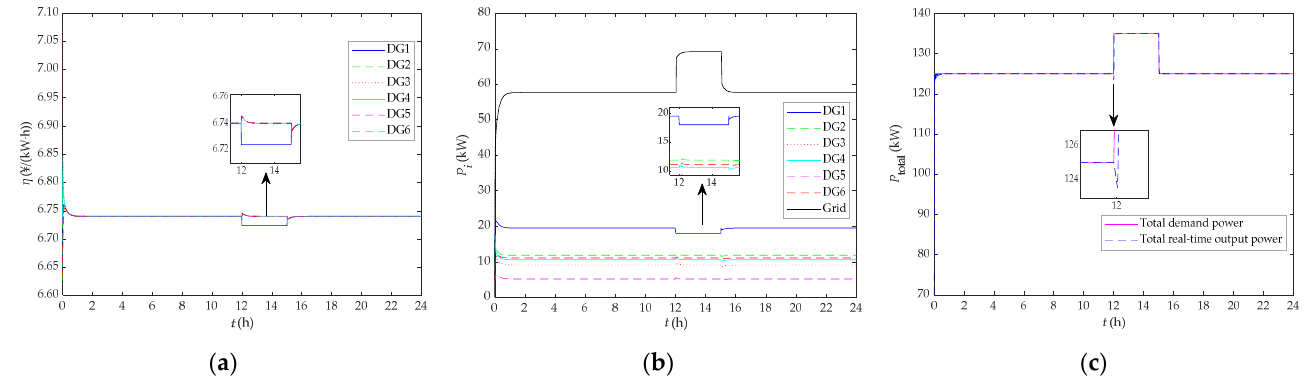
Figure 30. The change curves of variables of the system under DLR constraint: ( a ) change curves of each DG’s ICR; ( b ) change curves of each DG’s active output and grid output power; ( c ) change curves of the cumulative sum of each DG’s active output and grid output power as well as total demand